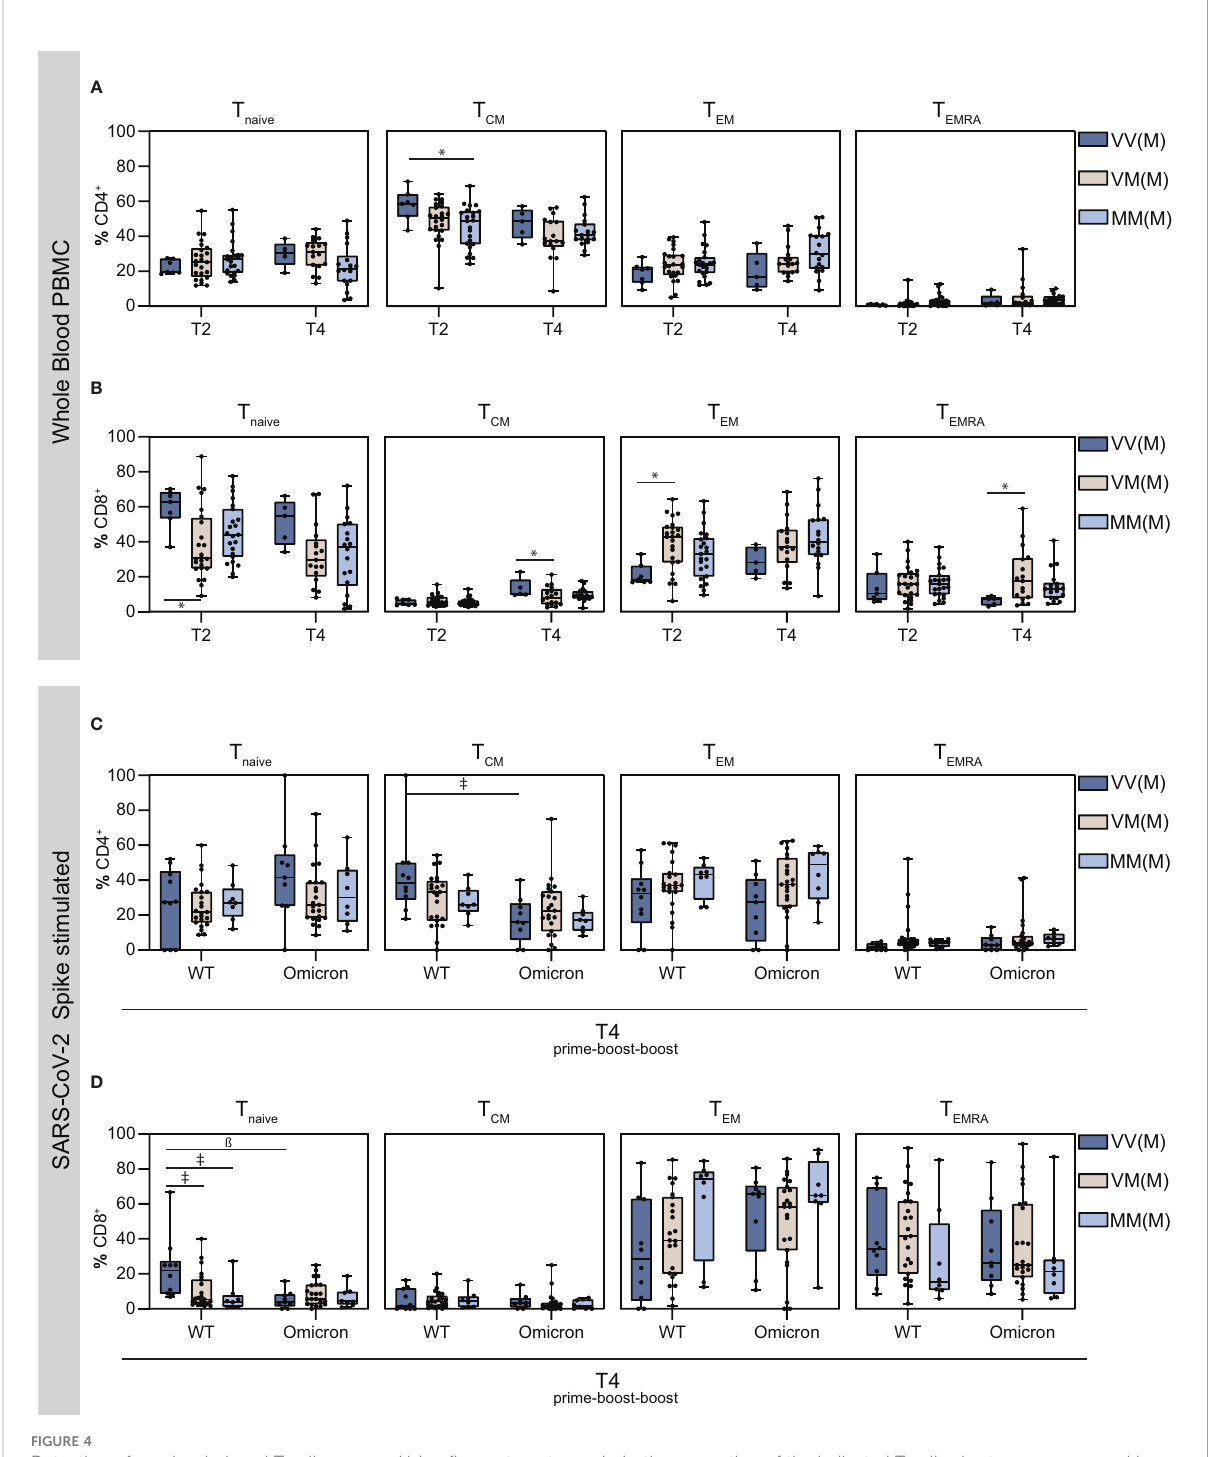
FIGURE 4 Detection of vaccine-induced T cell memory. Using fl ow cytometry analysis, the proportion of the indicated T cell subsets were measured in total PBMCs. (A – D) naïve, central memory, effector memory and effector memory cells re-expressing CD45RA T cell subsets on T2 and T4 in CD4 + T cells (A) , CD8 + T cells (B) and on T4 in Spike-stimulated activated CD4 + T cells (C) and activated CD8 + T cells (D) . Statistical analysis was performed using Tukey ’ s multiple comparison test to compare the vaccine regimens with each other and S ̌ ida ́ k ’ s multiple comparison test to compare WT vs. Omicron BA.1 for each vaccine regimen (* p = 0.05; ǂ p = 0.01; ß p = 0.001, # p =